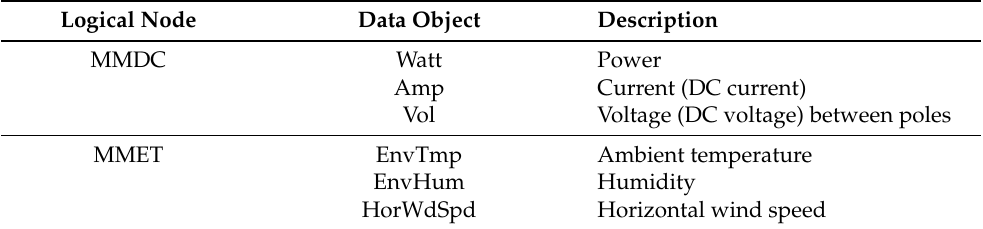
Table 3. Dataset used in the